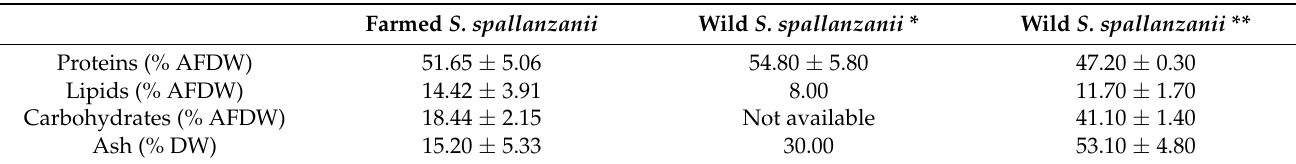
Table 1. Mean content ± S.D. of proteins, lipids, and carbohydrates as % ash free dry weight (% ASDW) in farmed and wild specimens of S. spallanzanii .